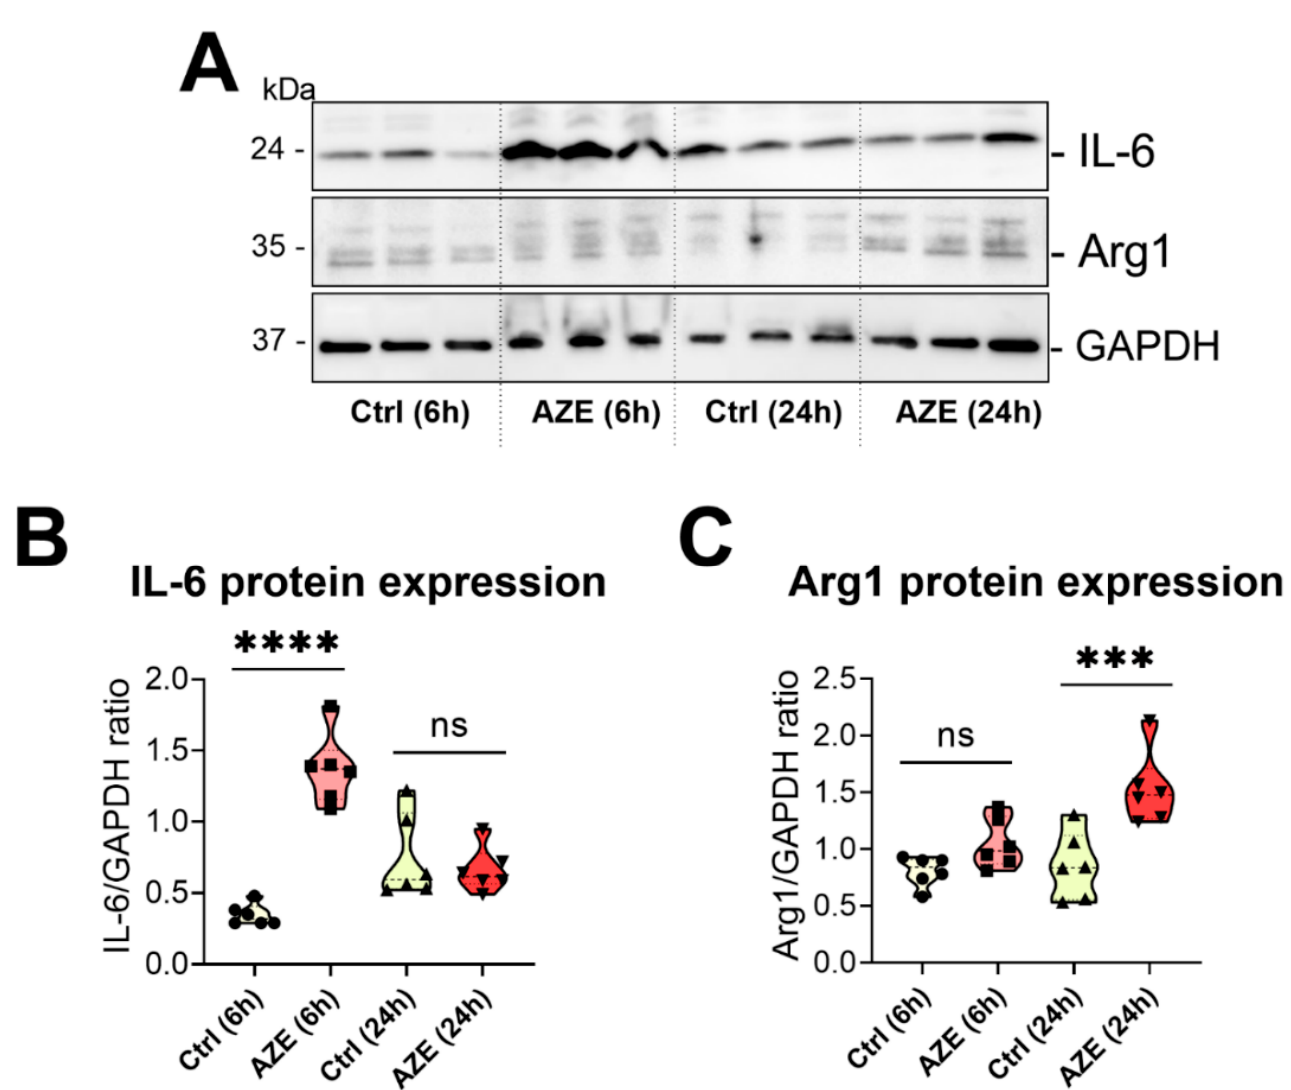
Figure 4. ( A ) Representative Western blots showing the protein expression of IL-6 and Arg1 in BV2 cells cultured or not in the presence of AZE (1000 µ M) for 6 or 24 h. ( B , C ) Violin plots of bands densities demonstrating the effects of AZE on the expression of IL-6 and Arg1 at the indicated times. Data reported is the mean ± SEM, from two independent experiments using separate batches of cells (n = 6). GAPDH was used as loading control. Ns = not significant. *** p < 0.001 or **** p < 0.0001 vs. Ctrl at the indicated time, as determined by ANOVA followed by Sidak’s post hoc test.